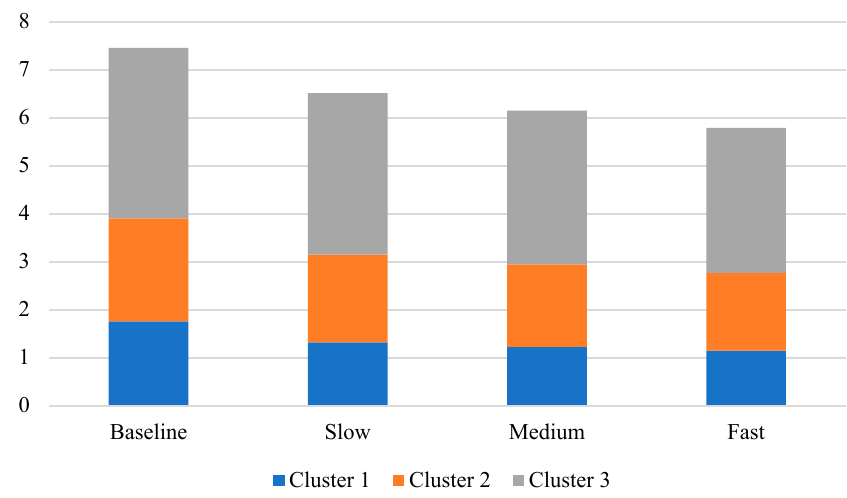
Figure 8. Fuel demand under di ff erent substitution scenarios (hundred million tons).